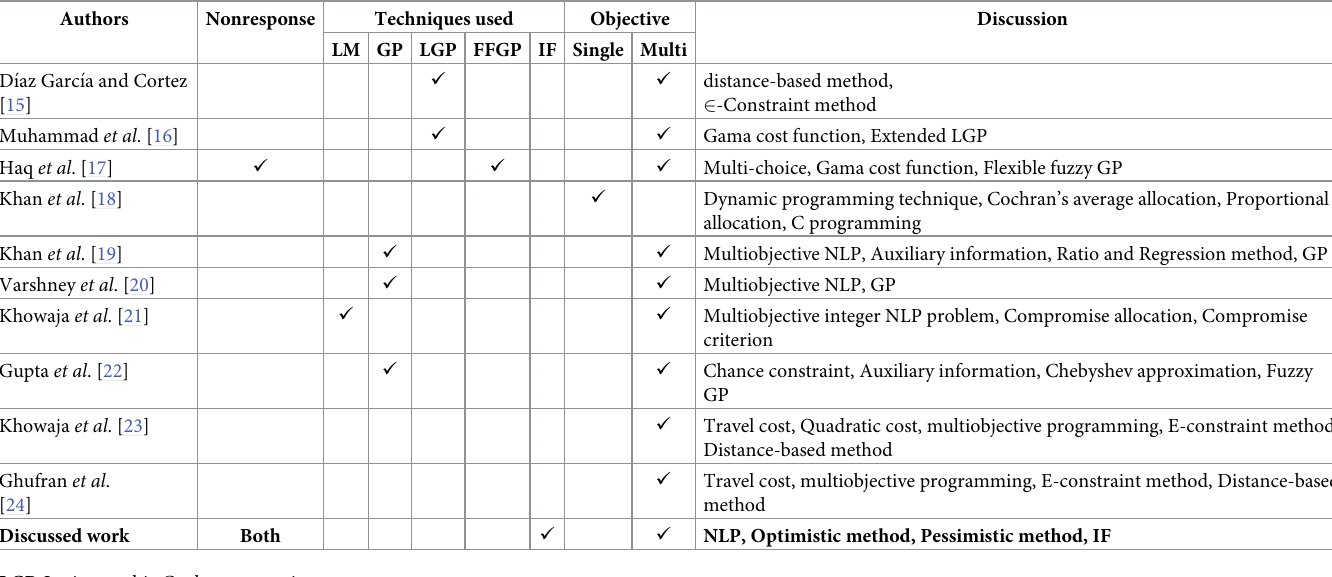
Table 1. Summary of research